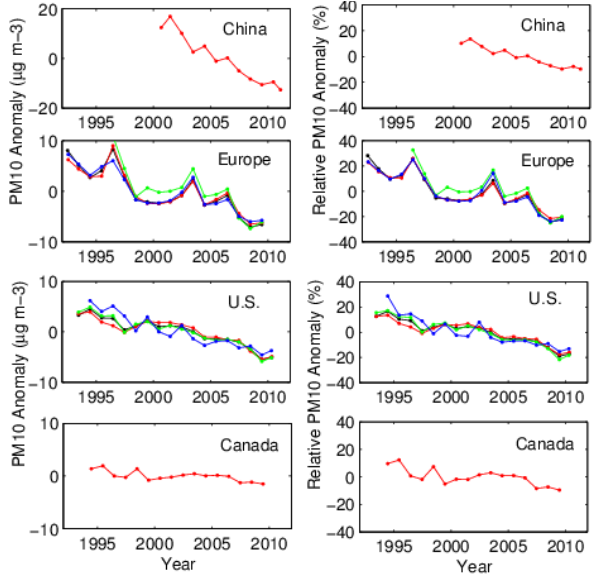
Fig. 4. Annual anomalies (left) of PM 10 and their relative anoma- lies (normalized by multi-year averaged PM 10 value from each site) (right). Black lines represent averages over total sites, red lines rep- resent urban averages, green lines represent suburban averages, and blue lines represent rural averages. Multi-year regional averages of PM 10 can be found in Table